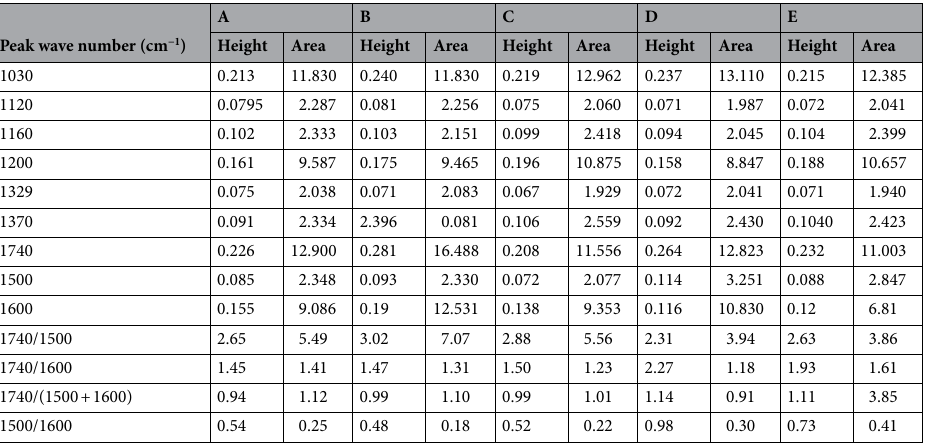
Table 4. Peak height and area of five different chestnut stands on the Amiata mountain according to Pandey (1999) and Naumann et al. (2007) 47 . 1740 cm −1 = Holocellulose band, 1500 cm −1 = Band related to wood